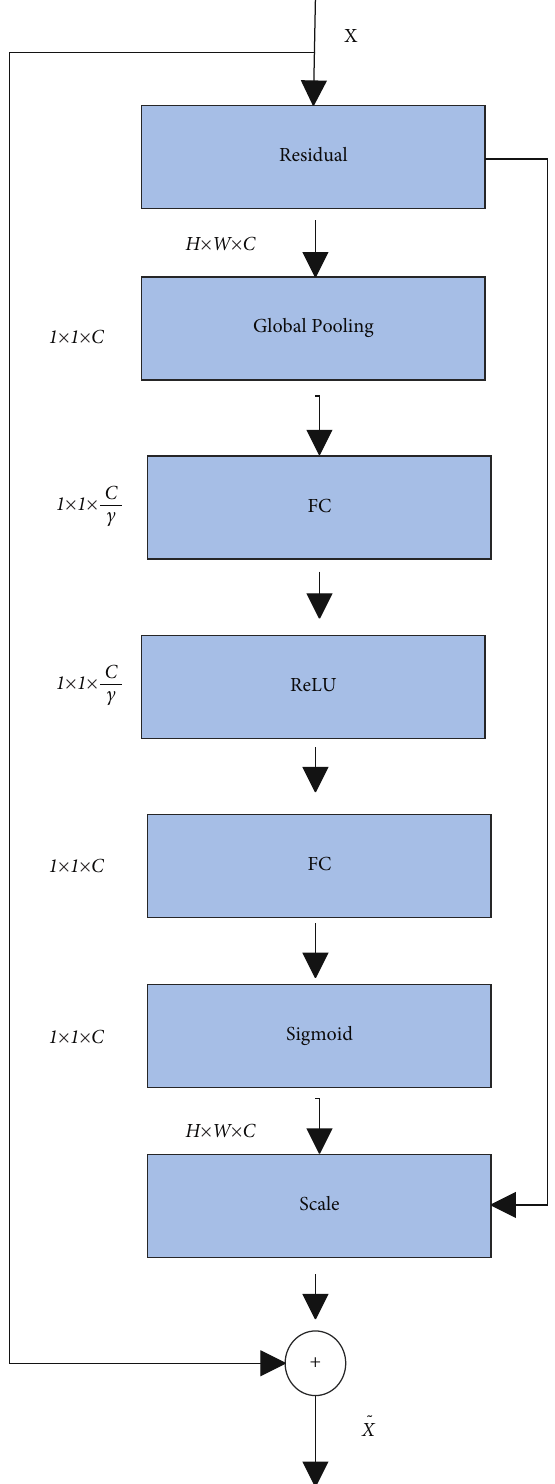
Figure 4: Network architecture of intelligent teaching method t